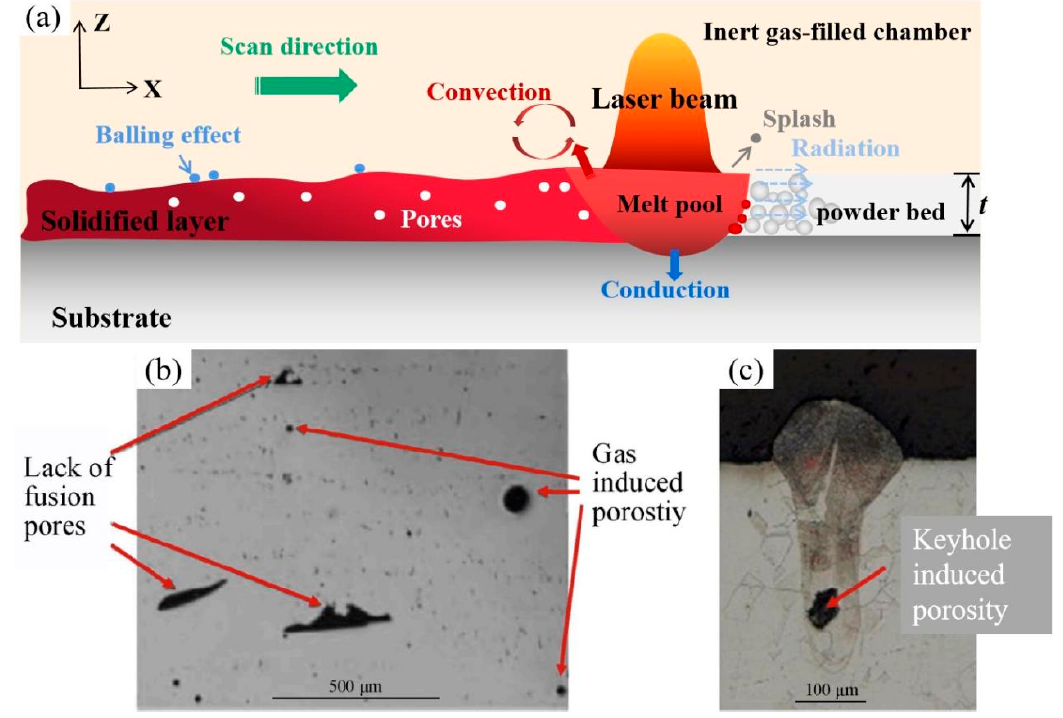
Figure 11. ( a ) Schematic overview of the interaction zone between the laser and powder bed; ( b ) Lack of fusion and gas-induced porosity [140]; ( c ) Keyhole-induced porosity in the LPBF process [139].